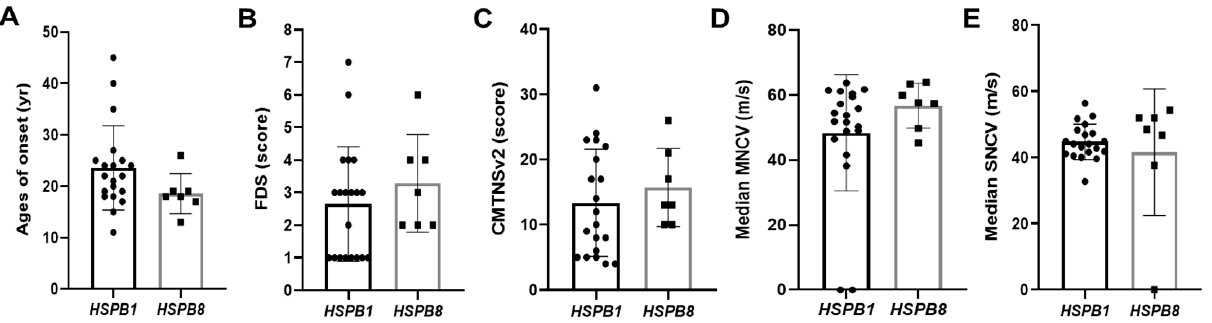
Figure 5. Comparison of clinical and electrophysiological phenotypes between two patient groups having mutations alternatively in HSPB1 and HSPB8 . The patients were classified into two groups of HSPB1 and HSPB8 , then their phenotypic values were compared. ( A ) Age of onset, ( B ) FDS, ( C ) CMTNSv2, ( D ) median MNCV, and ( E ) median SNCV.